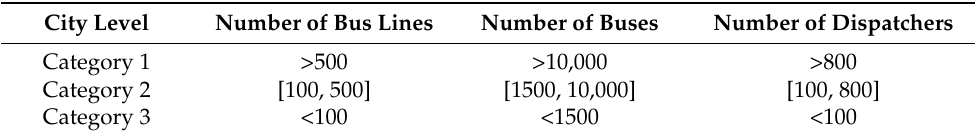
Table 3. Standards of urban grade from the perspective of public